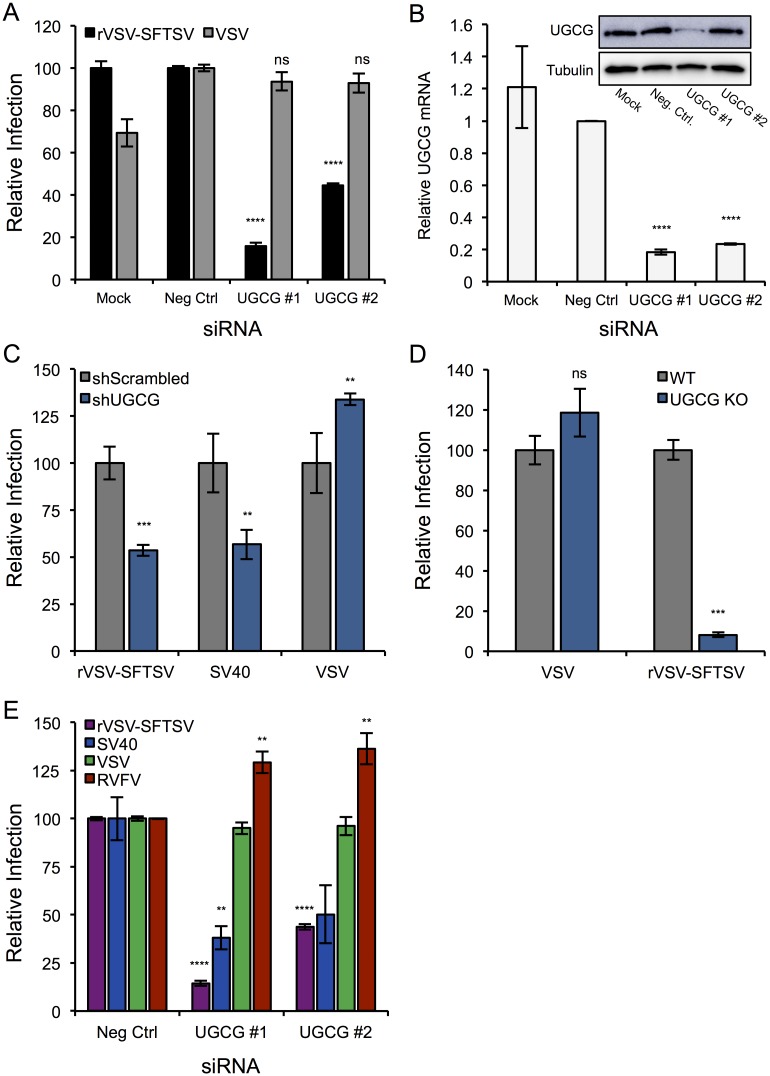
RNAi confirms role for UGCG in SFTSV entry.(A) U-2 OS cells were transfected with non-targeting (Neg Ctrl) or UGCG siRNAs and 72 hours post-transfection were infected with rVSV-SFTSV or VSV. Ten hours post-infection cells were harvested, immunostained for VSV M expression, and analyzed by flow cytometry. Infection levels are normalized to the negative control siRNA and expressed as relative infection. Mean ± S.E.M. for 3 independent experiments. (B) RNA was collected in parallel at the time of infection from the siRNA treated cells in (A). RT-qPCR was performed and UGCG mRNA was normalized to GAPDH mRNA and expressed relative to the negative control siRNA. Western Blot for UGCG protein expression shown in the inset. (C) U-2 OS cells were transduced with lentiviral shRNA constructs containing scrambled or UGCG-targeting shRNAs. Following puromycin selection, cells were infected with rVSV-SFTSV, VSV, or SV40 and harvested 10 hours (rVSV-SFTSV, VSV) or 24 hours (SV40) post-infection, immunostained for viral antigen, and quantified by flow cytometry. Mean ± S.E.M. for 2 independent experiments. (D) HAP1 UGCG KO cells or parental HAP1 cells were plated in 24 well plates and the next day infected with rVSV-SFTSV or VSV. Ten hours later, cells were collected, immunostained for VSV M expression, and analyzed by flow cytometry. Infection levels are normalized to parental HAP1 cells and expressed as relative infection. Mean ± S.E.M. for 3 independent experiments. (E) U-2 OS cells transfected with negative control or UGCG siRNAs were infected with rVSV-SFTSV, VSV, SV40 or Rift Valley fever virus (RVFV) 72 hours post-transfection. Cells were harvested 10 hours (rVSV-SFTSV, VSV, RVFV) or 24 hours (SV40) post-infection, immunostained for viral antigen, and analyzed by flow cytometry. Mean ± S.E.M. for 3 independent experiments. ** p<0.01, *** p<0.001, **** p<0.0001 using Student’s t-test with Bonferroni correction.